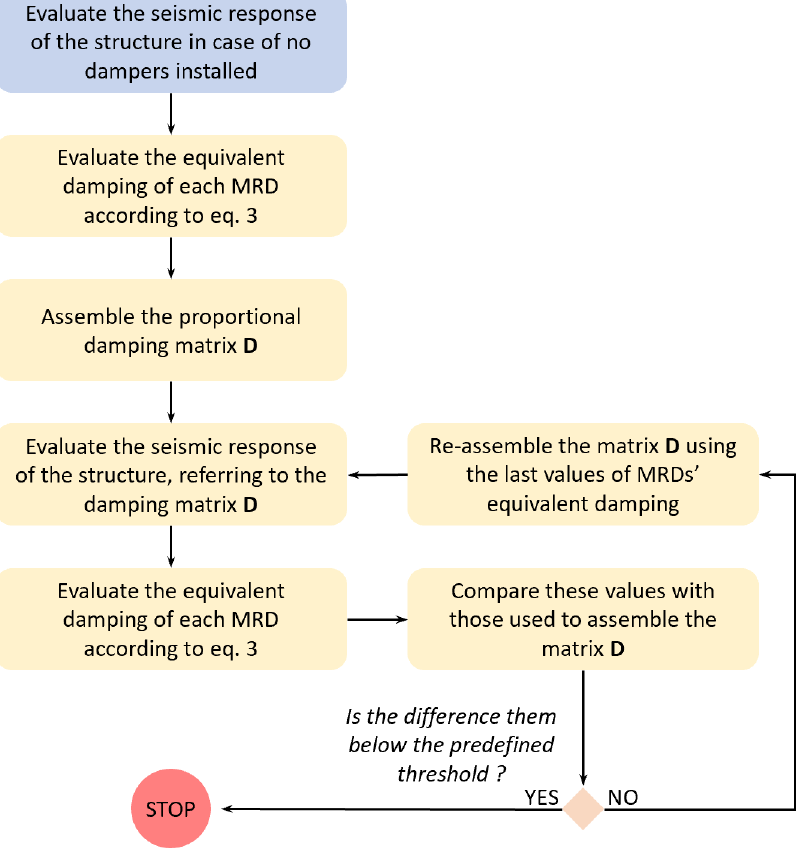
Figure 25. Iterative method for the calculation of MRDs’ equivalent damping.